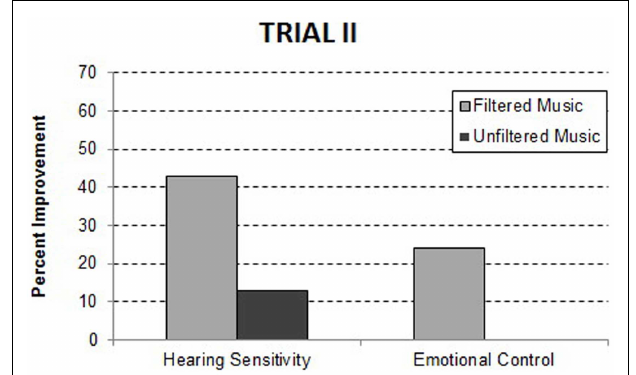
FIGURE 2 | Behavioral improvements at the 1-week post treatment assessment inTrial II .The data are reported as the precent of participants with a specific behavioral problem who improved.